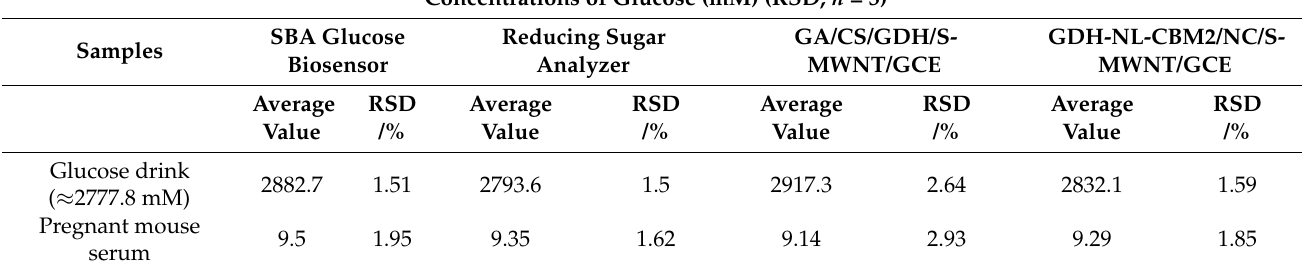
Table 2. Measurement of glucose in rat serum samples and glucose drinks using electrodes developed in this study and conventional